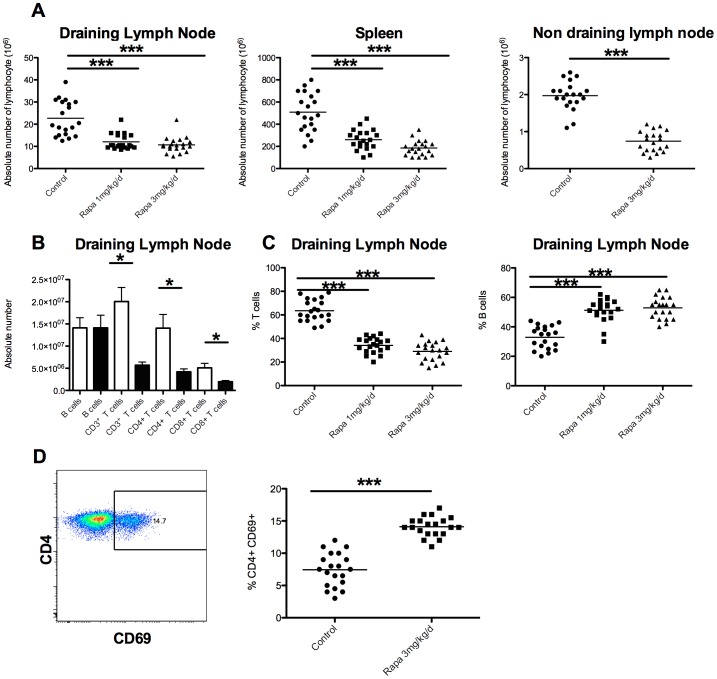
Rapamycin treatment induced a T cells lymphopenia sparing B cells.A: absolute lymphocyte number in draining lymph nodes, spleen, and non-draining lymph nodes is decreased in rapamycin-treated mice compare to controls in a dose-dependent fashion. B: quantification of the different sub-populations of lymphocytes: B lymphocytes (B, CD19+B220+), T (CD3+), T CD4+ (CD3+CD4+) and T CD8+ (CD3+CD8+) cells. * p<0.05, *** p<0.001. White histogram bars: control mice, black histogram bars: rapamycin treated mice (3 mg/kg/day). C: percent of T or B lymphocytes in draining lymph nodes. D: Representative dot plot of flow cytometry analysis of draining lymph nodes for percentage of pre-activated CD4+ T cell (CD3+CD4+FoxP3−CD69+) and percentage of pre-activated CD4+ T cell (CD3+CD4+FoxP3−CD69+) in controls and rapamycin (3 mg/kg/day) treated mice.